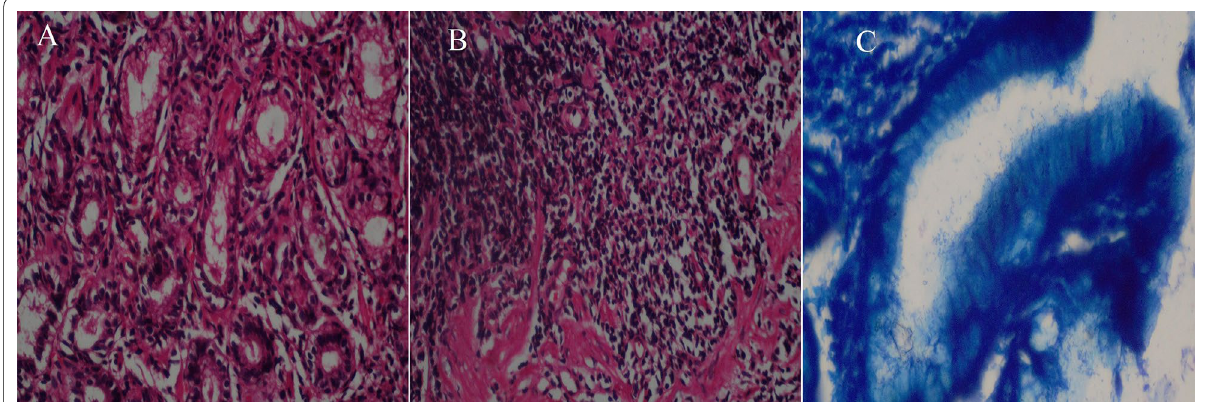
Fig. 5 Histological examination. A Gastric pits infiltrated by neutrophils in a case of H. pylori ‑positive. B Severe chronic gastritis with chronic inflammatory cells presents in the superficial lamina propria in excess of normal. C H. pylori organisms are present in the mucous layer on the gastric mucosal surface